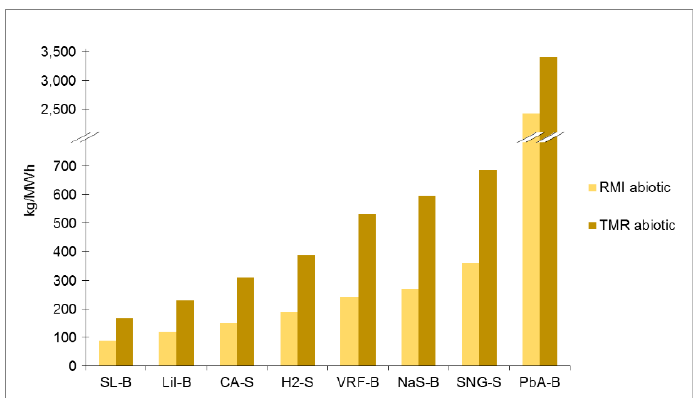
Figure 3. Raw material input abiotic RMI abiotic and total material requirement abiotic TMR abiotic per fed-out electricity of electrical energy storage technologies.